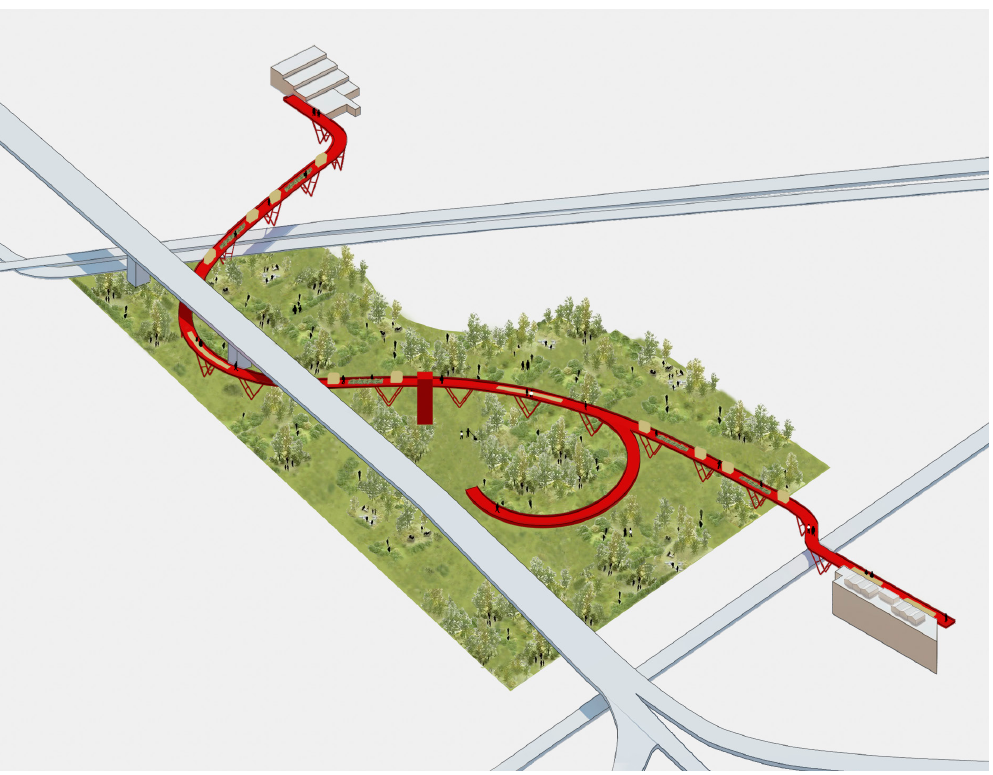
Fig. 6 Belardi, P., Battistoni, M., & Sorignani, C., Hortus line project (Perugia), axonometric projection,